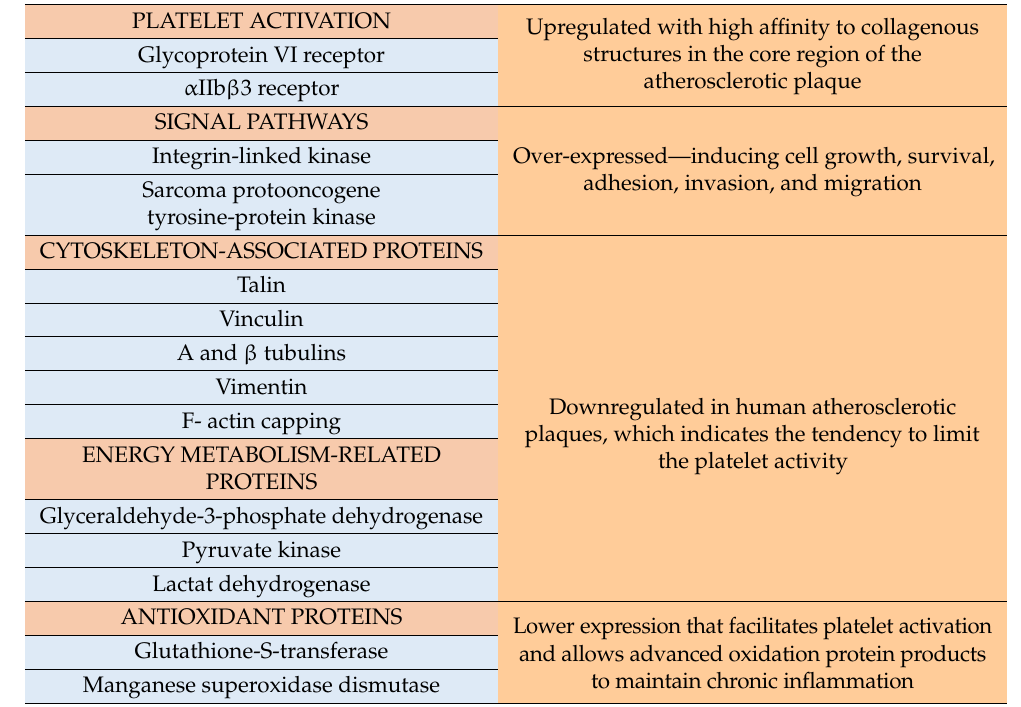
Table 3. Protein biomarkers classified into different functional groups by their role in favoring the instability of the atheroma plaque.